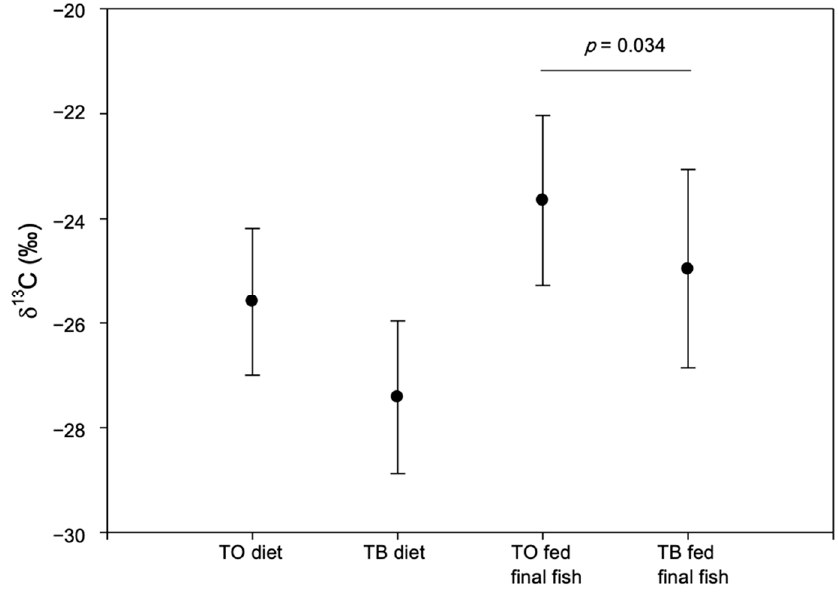
Figure 3. Mean stable isotope ratios of ω 3 fatty acids (18:3 ω 3, 20:5 ω 3 and 22:6 ω 3) in the diets and the salmon whole carcass at the end of the 70 day feeding period.